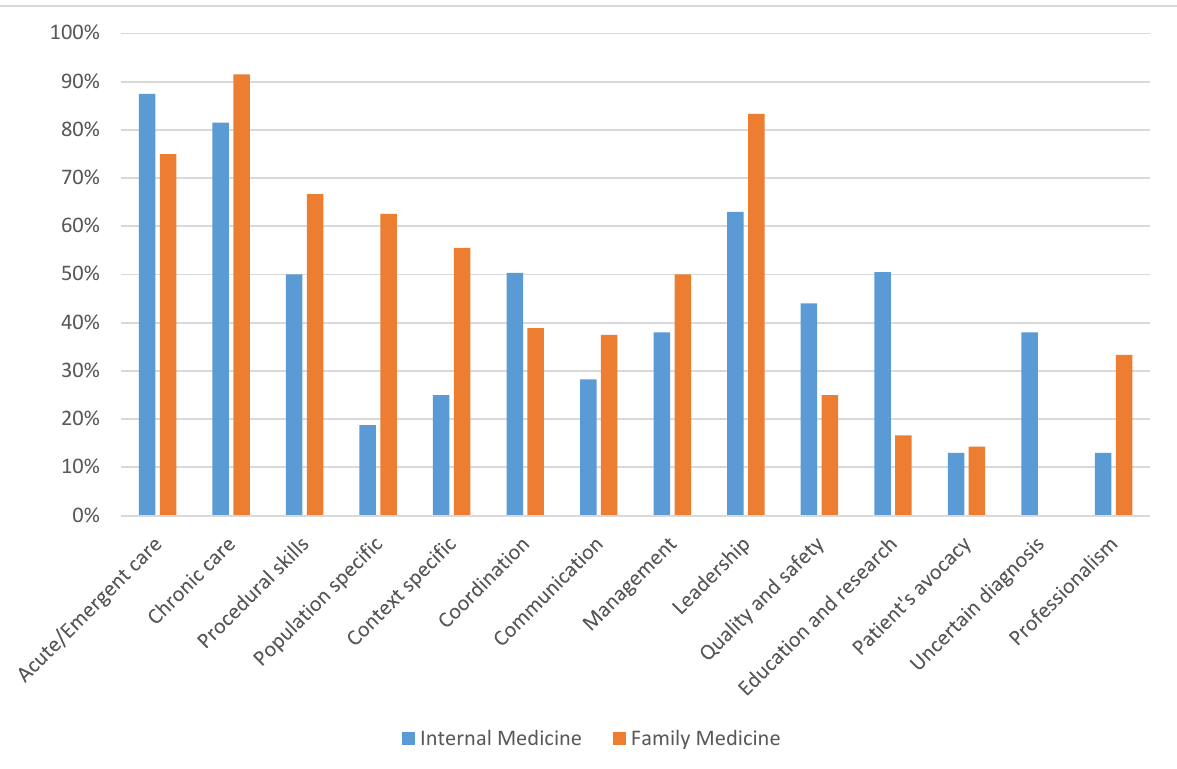
Figure 2: Proportion of articles with references to each theme in family medicine and internal